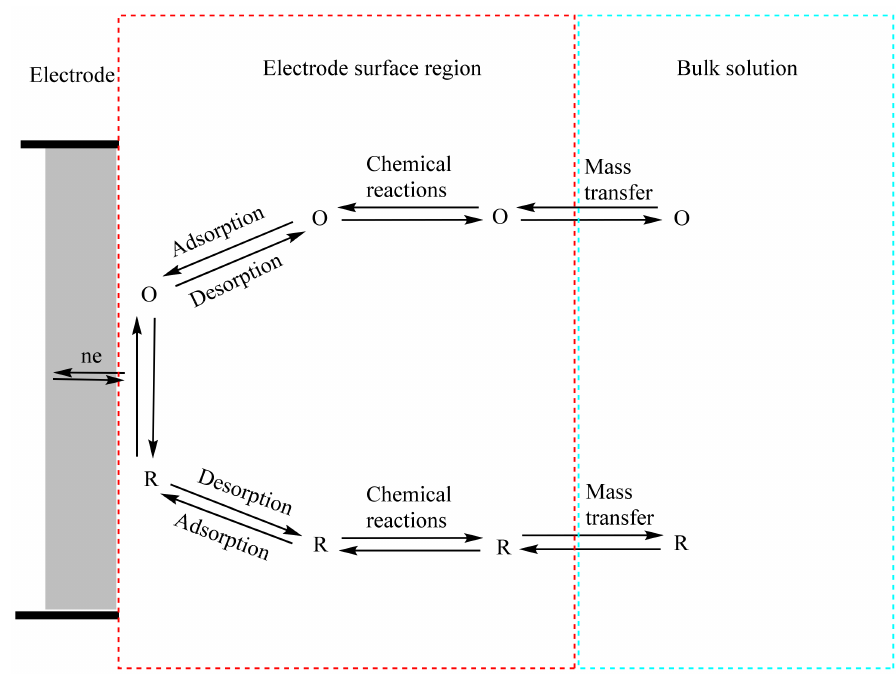
Figure 11. Illustrative pathway of a generalized electrode reaction. O and R represent the oxidized and reduced forms of the chemical species, respectively. Adapted with permission from Ref.